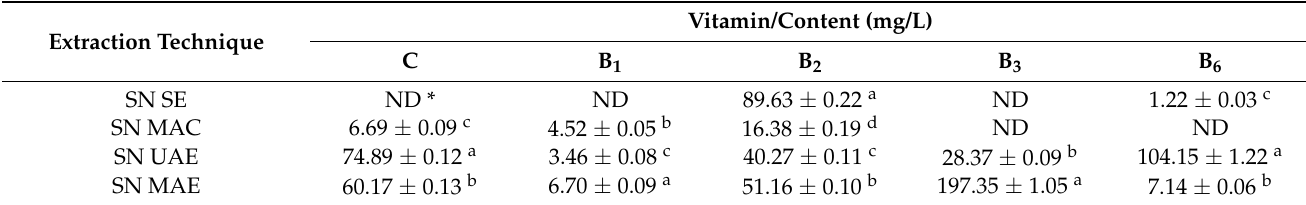
Table 2. Vitamins and their content in extracts prepared from stinging nettle